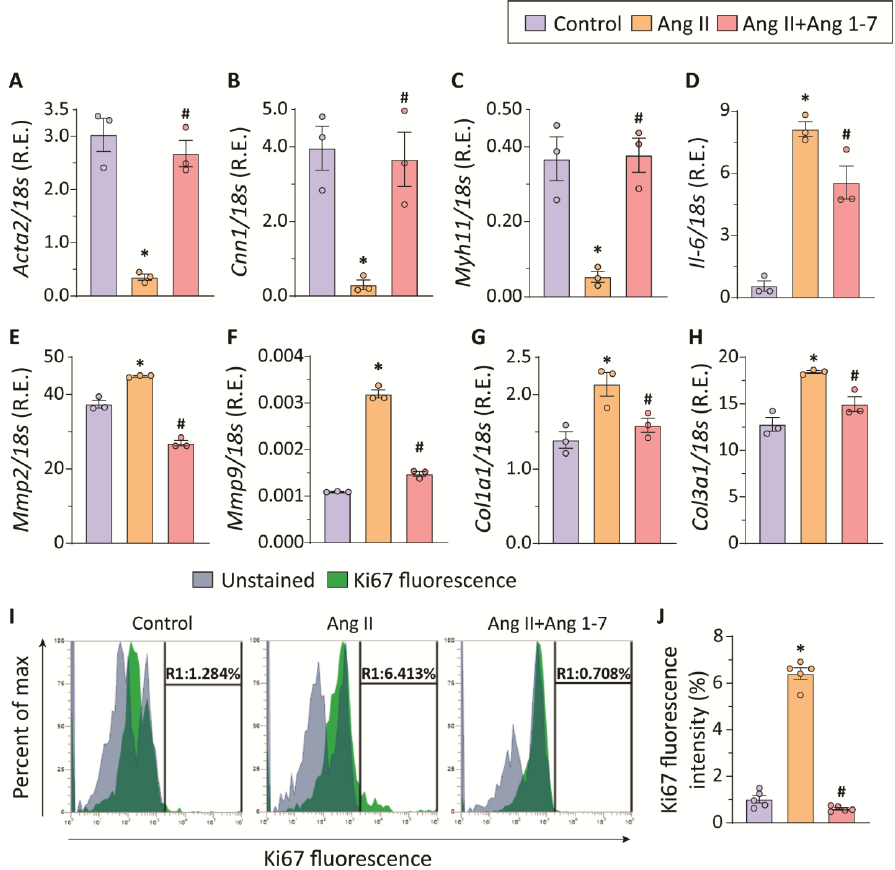
Figure 4. Ang 1-7 attenuates Ang II-mediated phenotypic switching and hyperproliferation of thoracic aortic vascular smooth muscle cells (VSMCs). TaqMan-qPCR-based mRNA expression analyses of alpha-smooth muscle actin ( Acta2 ; ( A )), calponin1 ( Cnn1 ; ( B )), myosin heavy chain 11 ( Myh11 ; ( C )), and interleukin-6 ( Il-6 ; ( D )) show the decreased expression of contractile genes and increased expression of the inflammatory gene in Ang II-treated thoracic SMCs. The mRNA expression analyses of matrix metalloproteinase 2 ( Mmp2 ; ( E )), matrix metalloproteinase 9 ( Mmp9 ; ( F )), collagen I ( Col1a1 ; ( G )), and collagen III ( Col3a1 ; ( H )) indicate pathological polarization of thoracic aortic SMCs to a “synthetic” phenotype in response to Ang II. Ang 1-7 treatment preserved the contractile phenotype of thoracic aortic SMCs (n = 3 in each group) ( A – H ). Flow cytometric analysis of Ki67 staining of thoracic aortic SMCs ( I ) and quantification of Ki67 fluorescence intensity ( J ) show increased Ki67-immunoreactivity in Ang II-treated VSMCs, indicative of hyperproliferation (n = 3 in each group). Chronic Ang 1-7 administration alleviated the Ang II-induced thoracic aortic SMC proliferation, as evident by decreased Ki67-immunoreactivity ( I , J ). * p < 0.05 compared with the control group; # p < 0.05 compared with the Ang II group using one-way